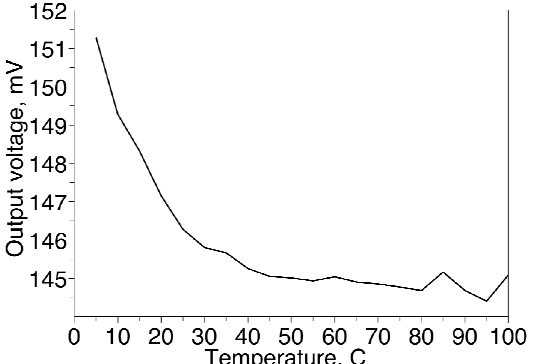
Figure 6. Temperature dependence of the sensor